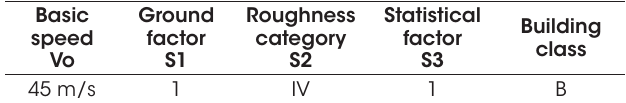
Parameters for wind loads Basic speed